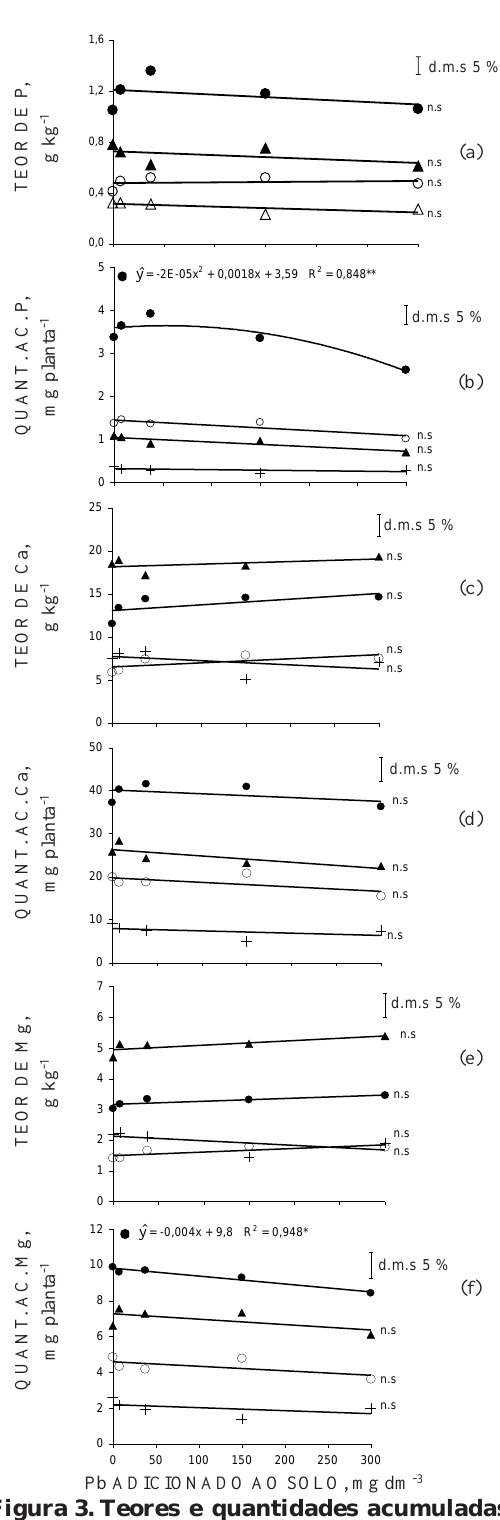
Figura 3. Teores e quantidades acumuladas de P (a,b), Ca (c,d) e Mg (e,f) na parte aérea da soja, considerando a dose de Pb adicionada ao solo = 63 %; sem FMA e V = 63 %; ( com FMA e V 1 1 com FMA e V = 82 %; + sem FMA e V = 82 %). 2 2 Valor do d.m.s a 5 % para comparar entre os FMAs e as V % dentro de cada dose de Pb (n.s: não-significativo;* p < 0,05; ** p <